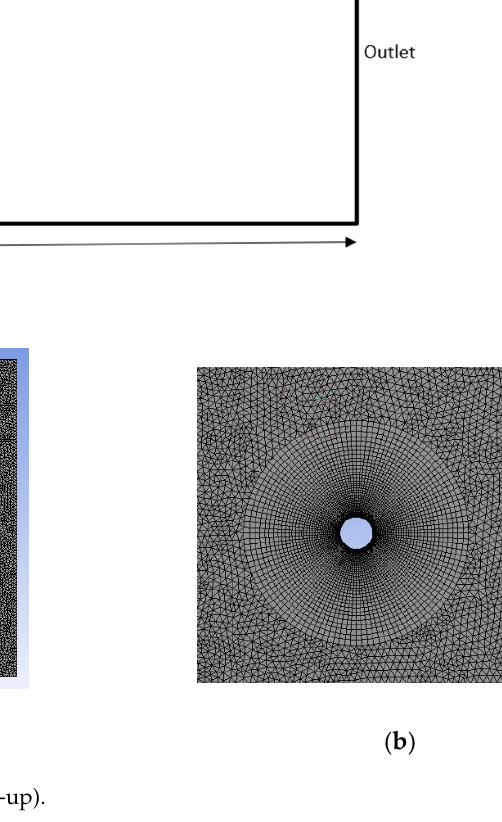
Figure 1. Computational domain.